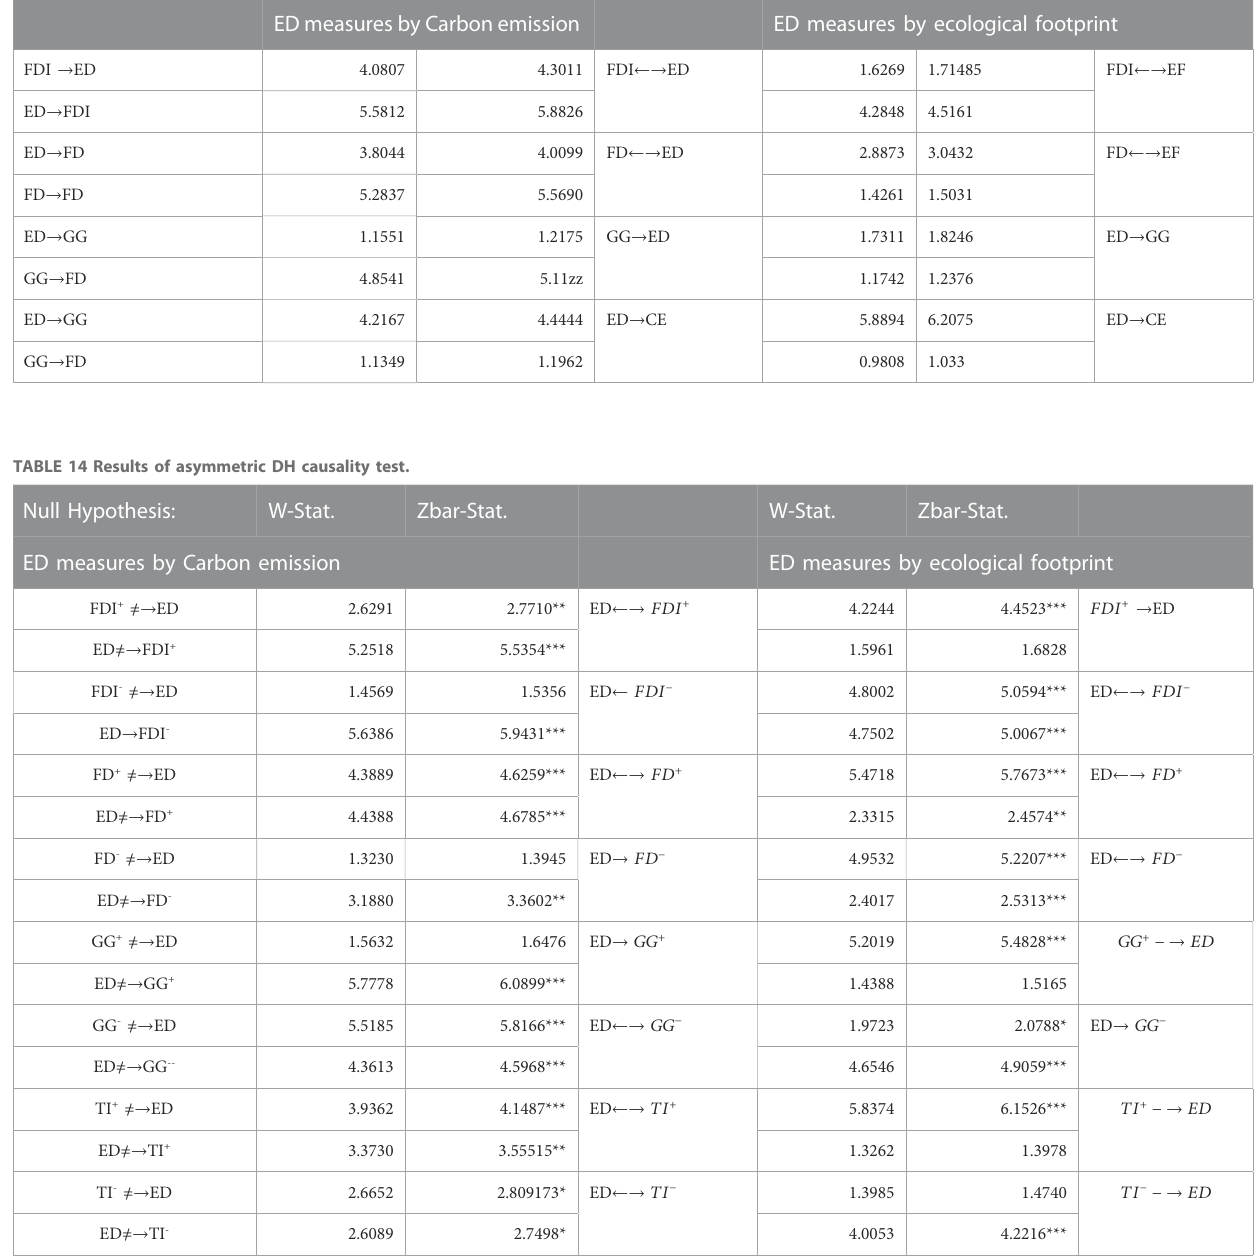
TABLE 13 DH-causality test. Null Hypothesis: W-Stat. Zbar-Stat. W-Stat.